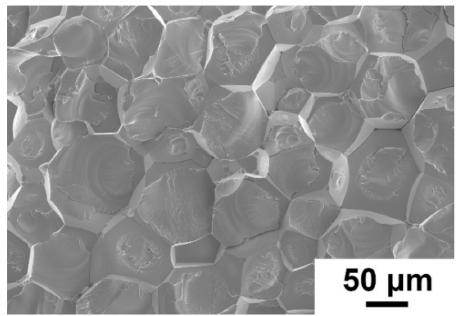
Figure 8. Surface morphology of a Zr 48 Cu 36 Al 8 Ag 8 bulk specimen consolidated at 743 K fractured upon release of the pressure during hot pressing showing the shape changes from spherical to